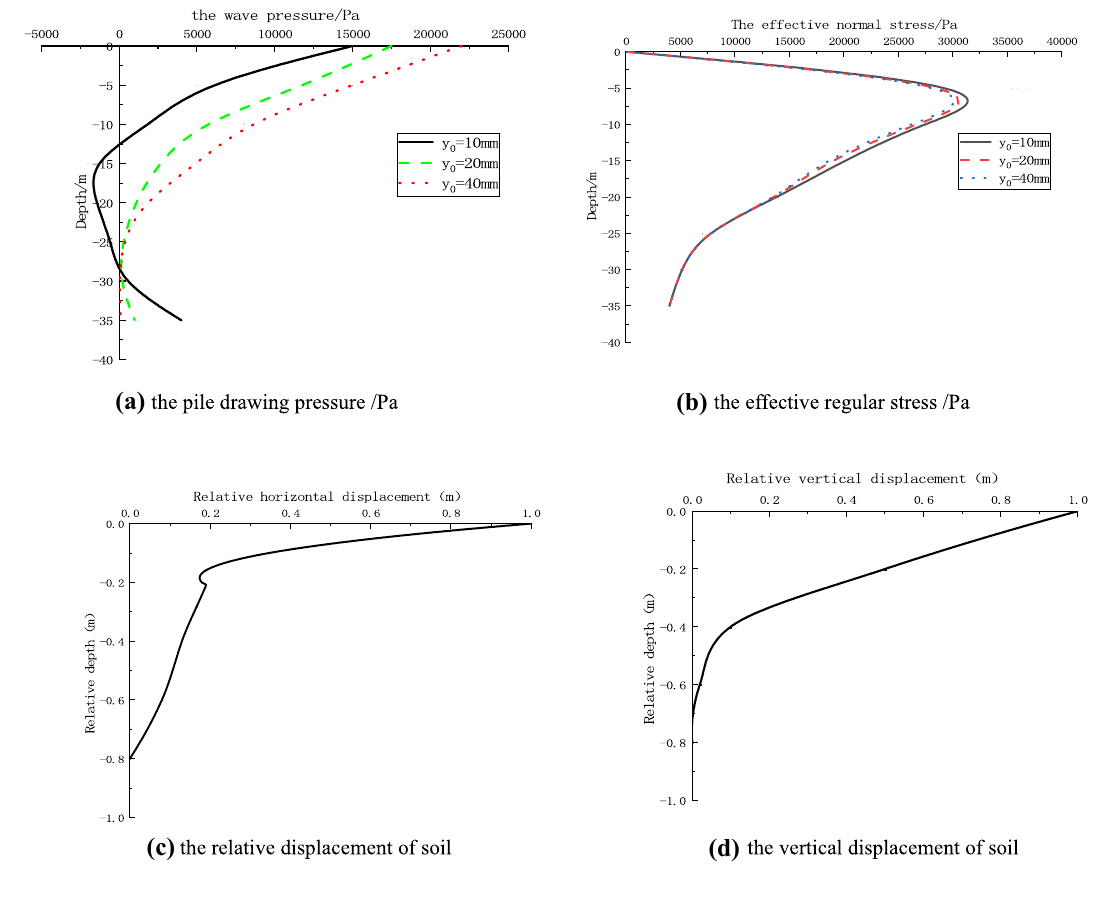
Fig. 10 The analysis of calculation